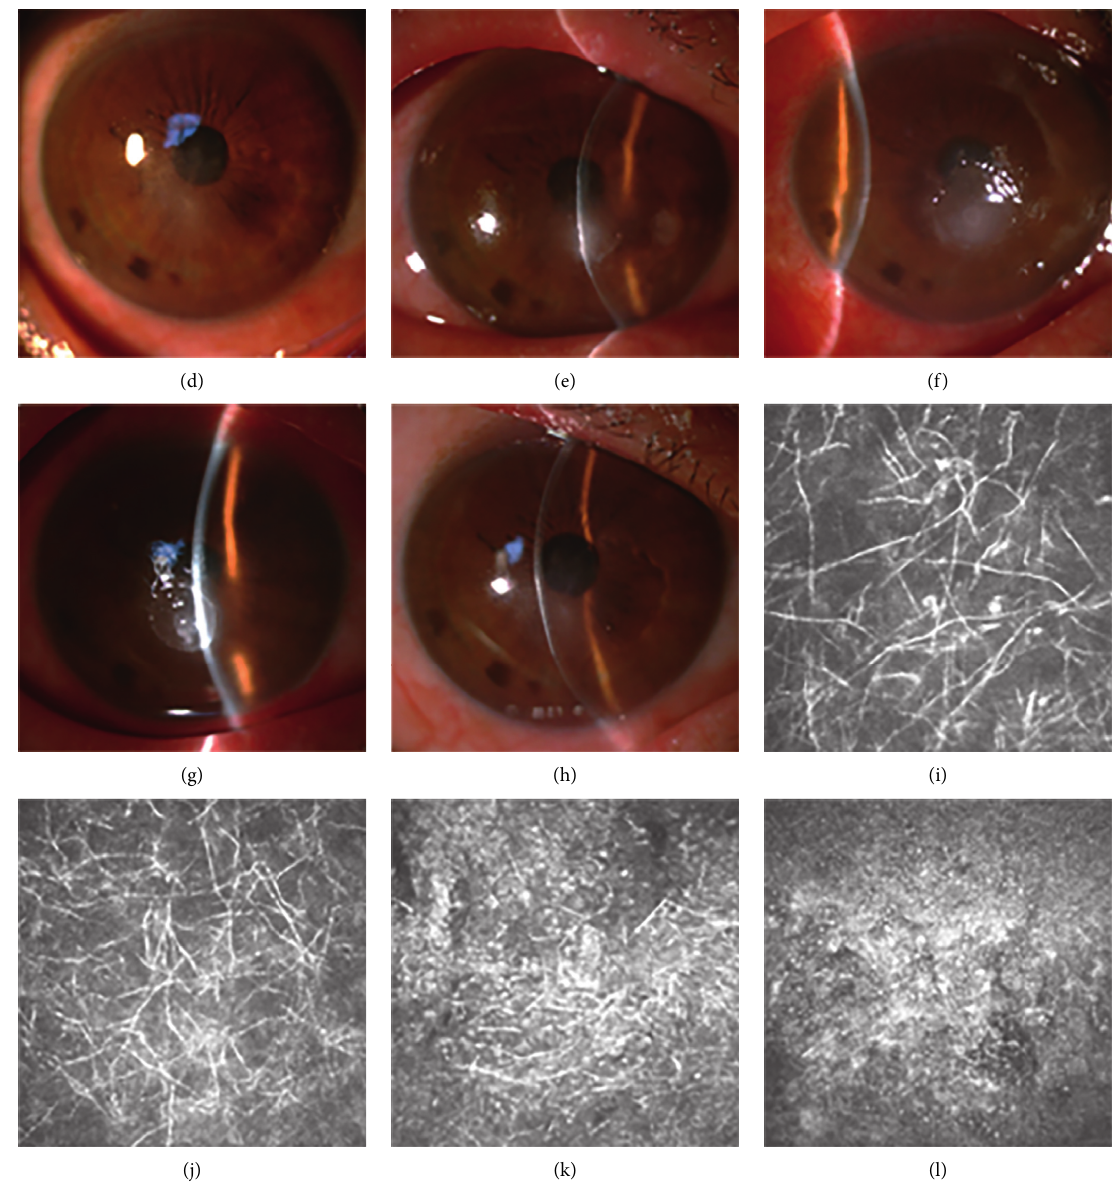
Figure 3: Case 2. (a, e) Anterior segment photograph at enrollment. (b, f) Anterior segment photograph before TCSI (after 5-day conventional antifungal treatment). (c, g) Anterior segment photograph 3 days after TCSI. (d, h) Anterior segment photograph when the patient has been healed. (i) IVCM examination at enrollment. (j) IVCM examination before TCSI (after 5-day conventional antifungal treatment). (k) IVCM examination 3 days after TCSI. (l) IVCM examination when the patient has been